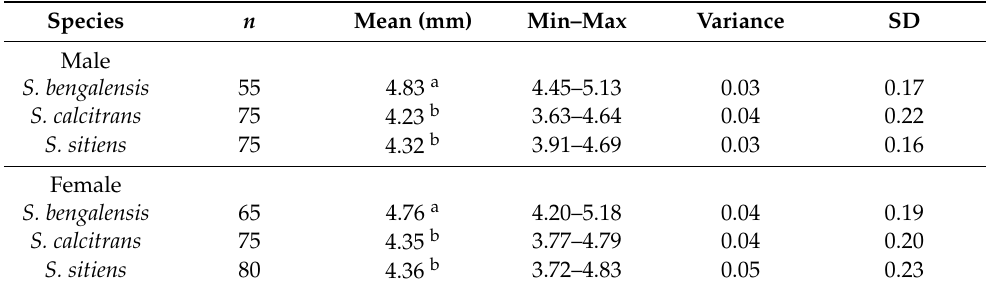
Table 2. Mean centroid size of male and female Stomoxys bengalensis , S. calcitrans , and S. sitiens and statistically significant